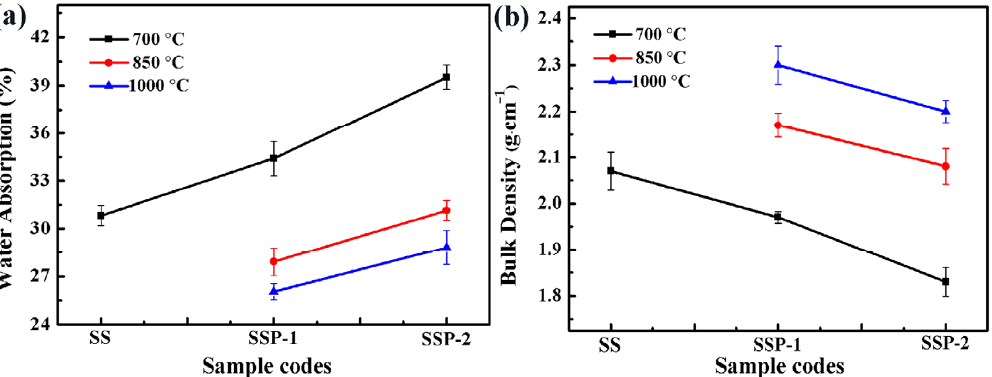
Figure 7. Water absorption ( a ) and bulk density ( b ) of all samples fired at 700, 850, and 1000 ° C for 30 min.